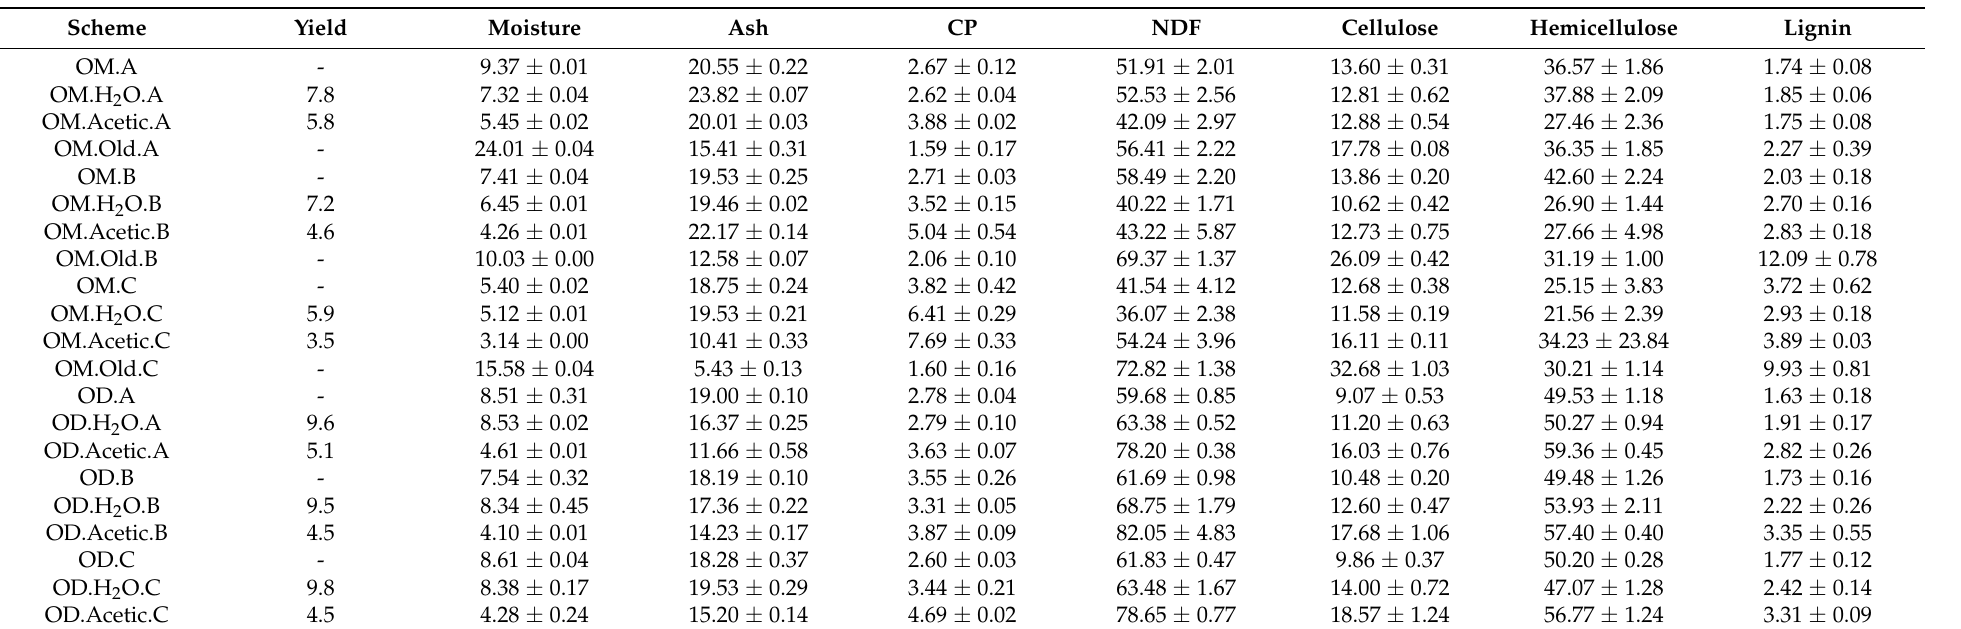
Table 3. Chemical composition of Opuntia cladodes (% wt in dry base).